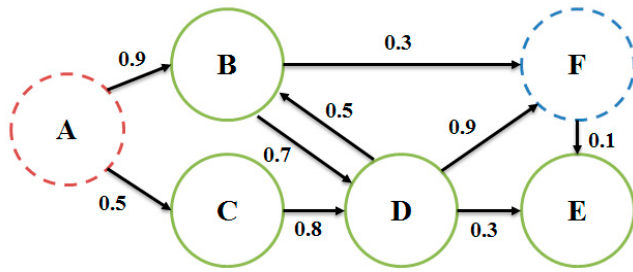
Figure 5. Trust network between users.